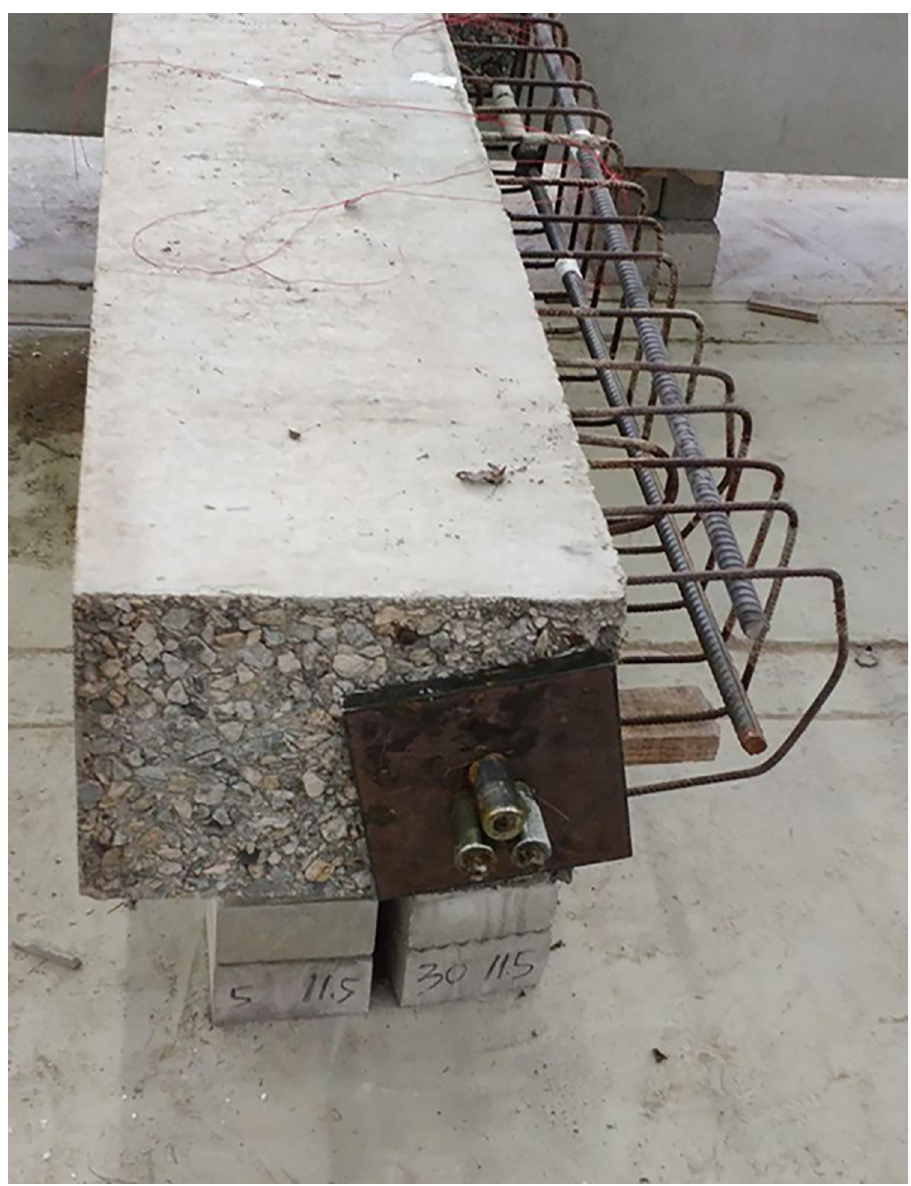
Fig 5. Installing prestressed